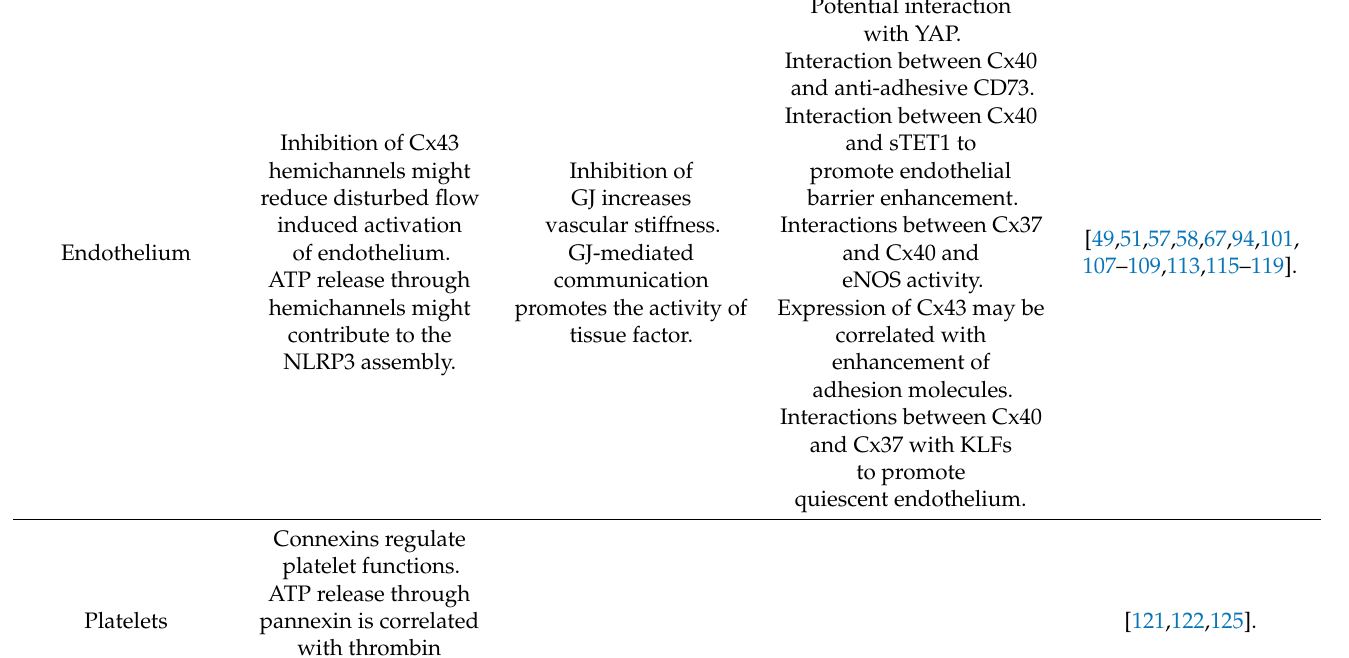
Table 1. Summary of the different roles of Cx isoforms in the promotion or suppression of atherosclerosis. Role of Hemichannels Role of Gap